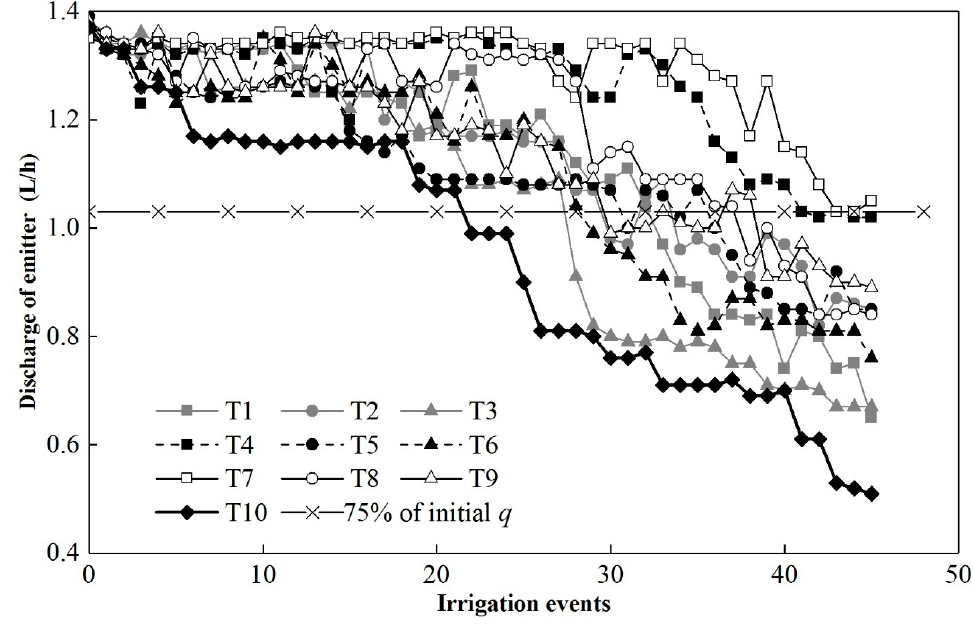
Figure 4. Average change in the emitter discharge versus irrigating events.